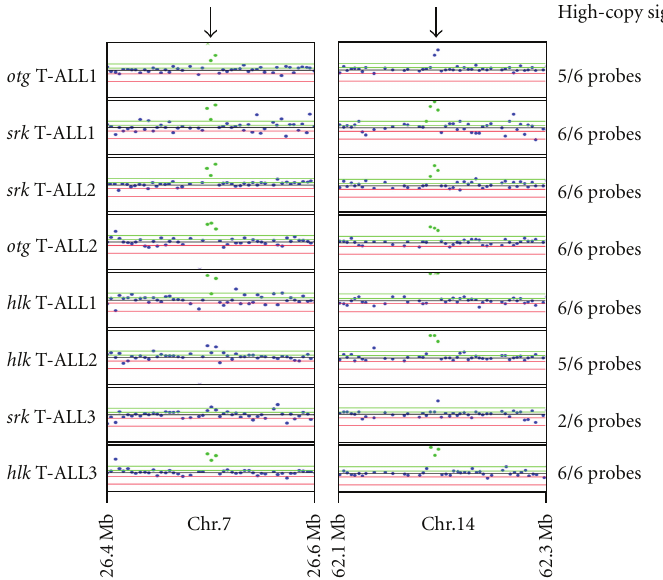
Figure 1: Recurrent amplifications of a small genomic locus in zebrafish T-ALL. Ten kb loci on chromosomes 7 and 14 (Zv6 genomic assembly) show high-copy gains with multiple probes in these regions (black arrows) of 8/8 D. rerio T-ALL samples tested. Signal intensities above a “high-copy gain threshold” (upper green line) indicate a greater than 2-fold increase in copy number. Individual probes and their intensities are depicted as blue dots; areas with 3 adjacent probes above the high-copy gain threshold use green dots to denote those probes. Seven cancers exhibited high-copy signals for ≥ 5/6 probes in this region, while srk T-ALL3 had high-copy signals for only 2/6